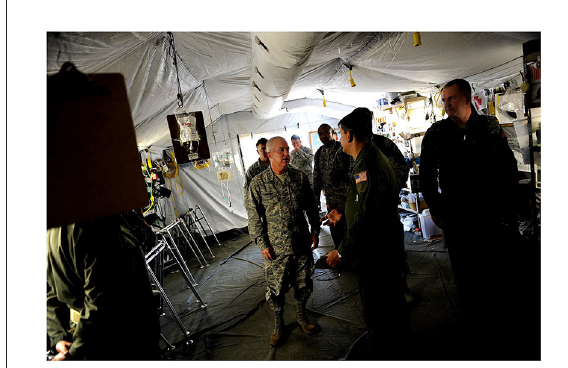
FIGURE4 Inside the AFSOC medical tent, U.S. Air Force AFSOC Commander Lt. Gen. Donald C. Wurster visits with his troops at the Toussaint Louverture International Airport, Port-au-Prince, Haiti, on January 27 during Operation Unified Response. DoD assets have been deployed to assist in the Haiti relief effort following a magnitude 7 earthquake that hit the city on January 12. The appearance of U.S. DoD visual information does not imply or constitute DoD endorsement. Source: Public domain image, not in copyright. Available at: https://commons. wikimedia.org/wiki/File:Operation_Unified_Response_ DVIDS244961.jpg.